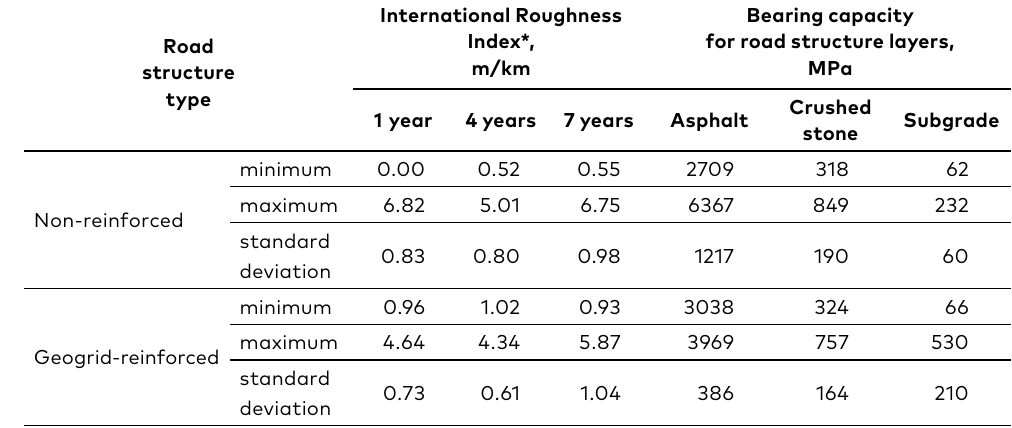
Table 1. Statistical values by subgrade type of